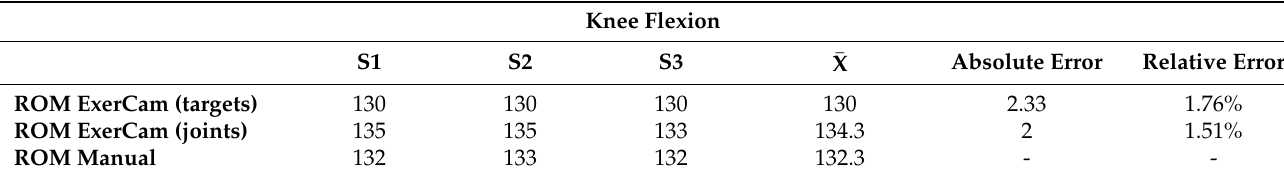
Table 6. Results of the measurements in the knee flexion task.